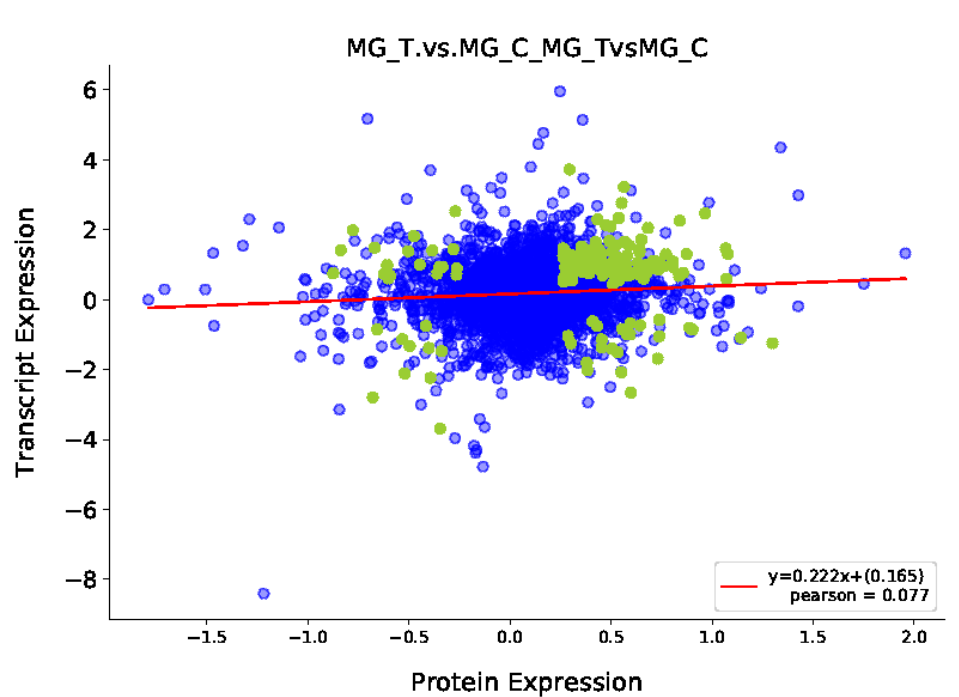
Figure 3. Correlation analysis of transcriptome and proteome expression. Note: Each dot repre- sents a protein, green dots represent proteins with significantly different expression, and blue dots represent proteins with no significant difference in expression.